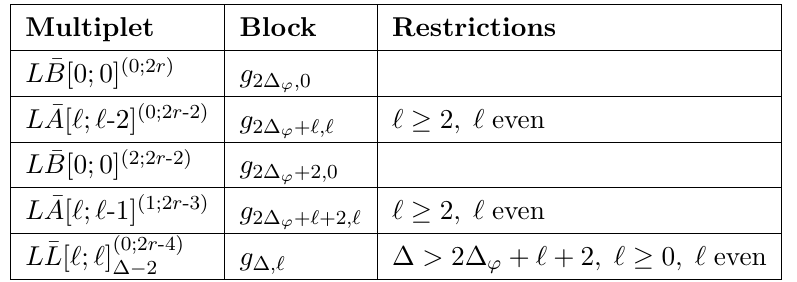
Table 2 . List of multiplets that appear in the ϕ r × ϕ r OPE, where ϕ r is the primary of N = 2 chiral multiplet. For each multiplet, only one conformal descendant appears in the OPE, so we obtain non-supersymmetric bosonic